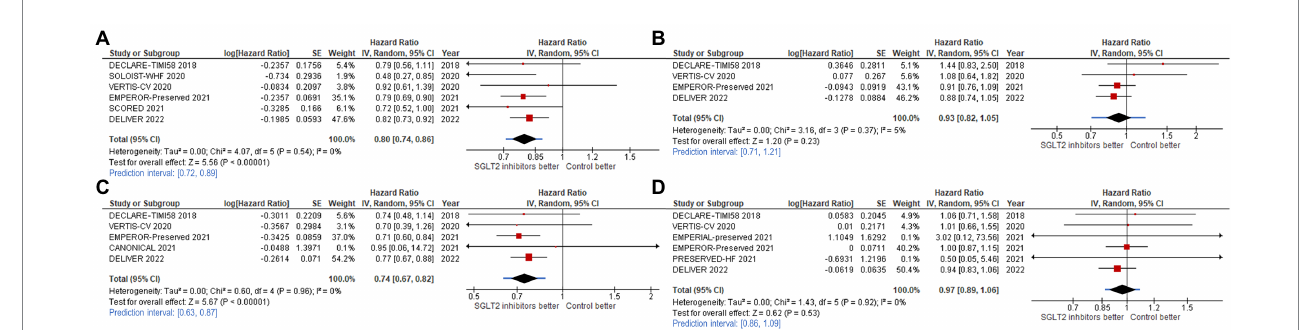
FIGURE 3 Forest plots of studies that investigated (A) CV death or HHF or urgent visit for heart failure (HF); (B) cardiovascular (CV) death; (C) hospitalization for heart failure (HHF); and, (D) all-cause death compared between patients receiving sodium-glucose cotransporter-2 (SGLT2) inhibitors and controls among all